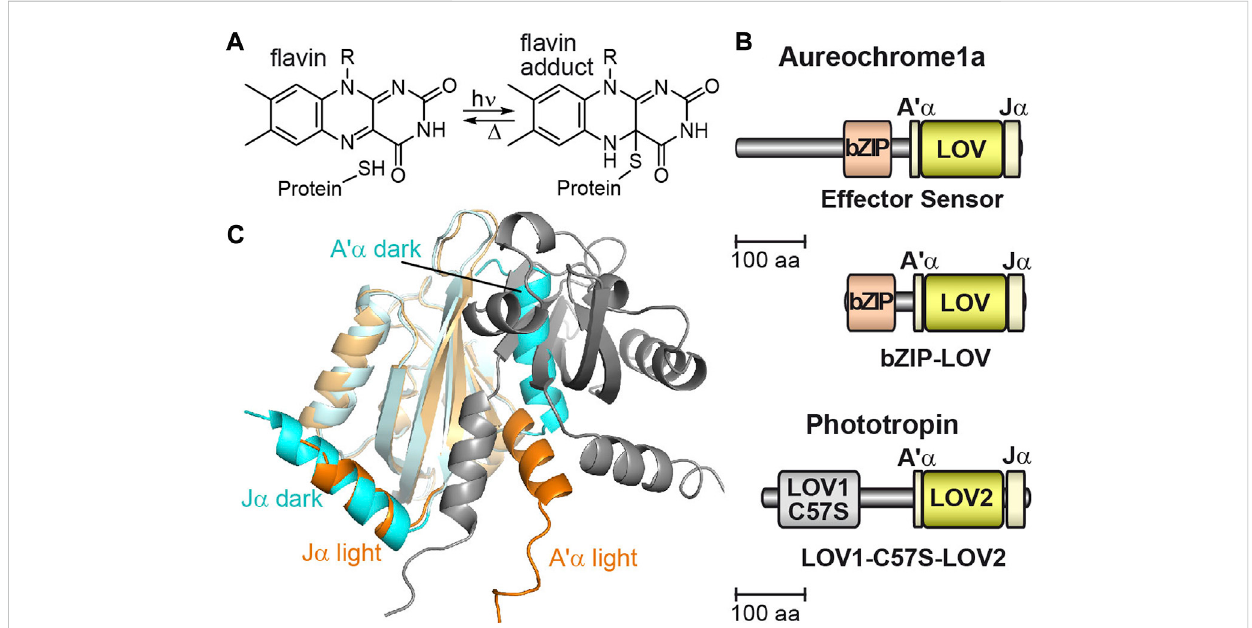
FIGURE 1 The fl avin photoreaction in LOV domains, the domain architecture of aureochrome and phototropin, and the crystal structure of the aureochrome LOV domain. (A) In LOV proteins, the non-covalently bound fl avin mononucleotide (FMN) reacts with a nearby located cysteine to the FMN adduct upon illumination. (B) The domain architecture of aureochrome is inverted compared to phototropin with an N-terminal bZIP effector domain and a C-terminal LOV domain. Phototropin possesses two sensory domains, LOV1 and LOV2, at the N-terminus and a C-terminal kinase as effector domain. Mutation of cysteine to serine in LOV1 (C57S) abolishes photoactivity. (C) The monomeric crystal structure of LOV from Pt Aureo1a in the dark (PDB: 5a8b, cyan) shows association of the A ’ α helix to the β -sheet blocking the dimerization surface. Upon illumination, the J α helix partially unfolds, which results in the release and partial unfolding of the A ’ α helix enabling dimerization of two light state LOV domains (PDB: 5dkl, orange, and